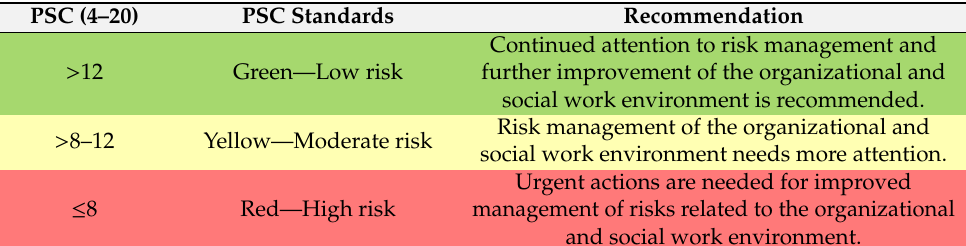
Table 3. PSC-4 benchmark standards and recommendations.